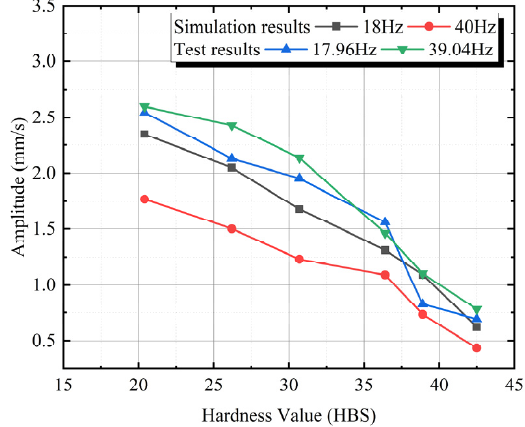
Figure 18. Hardness affects torsional vibration .